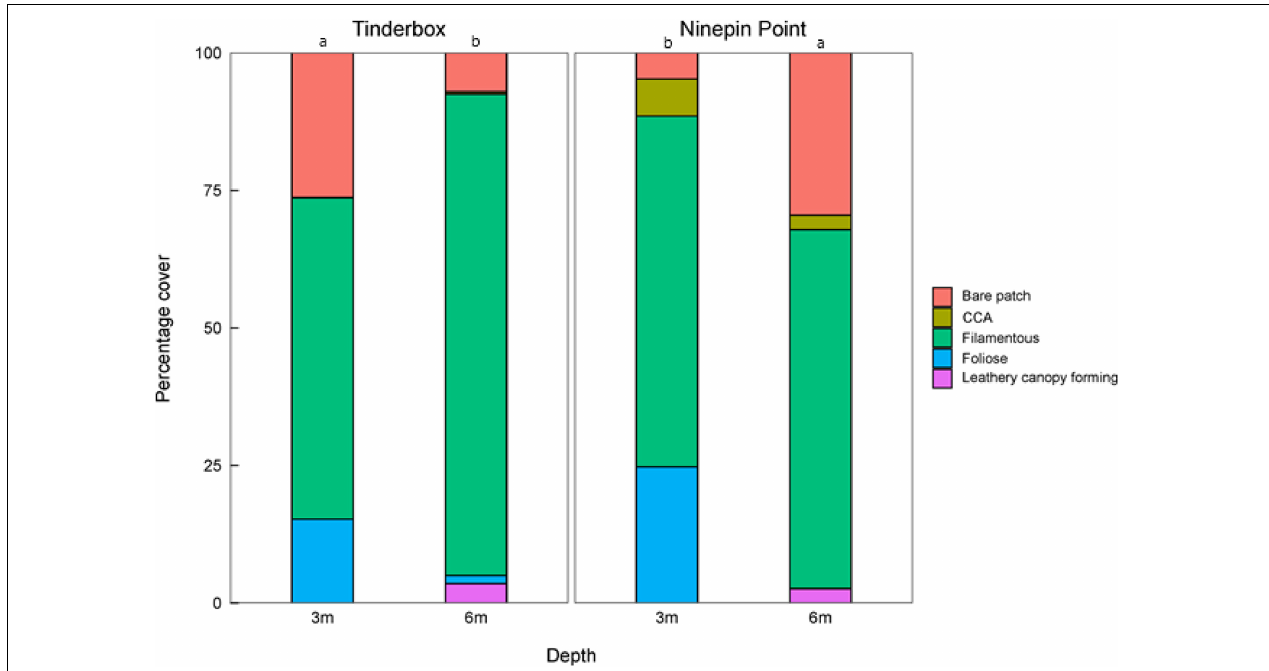
FIGURE 5 | Proportion of cover of bare substrate, crustose coralline algae (CCA), filamentous, foliose, and leathery canopy forming macroalgae at Ninepin Point and Tinderbox at two depths, 3 and 6 m. Note that cover equates to the percentage of the understorey canopy macroalgae only. Letters denote significant difference of percent cover of macroalgae between sites and depth (LSD), P <